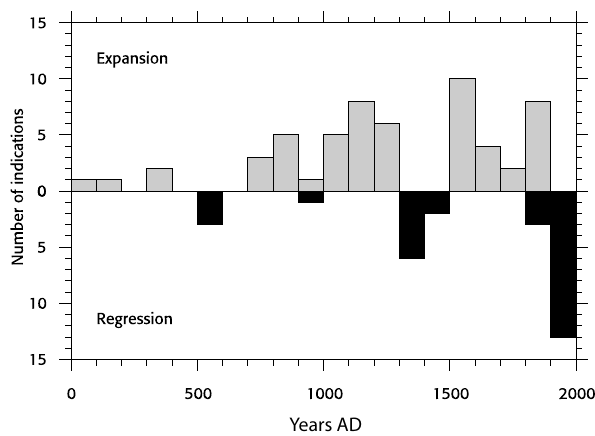
Fig. 5. Indicators of land-use expansion and regression during the last 2000 years in Southern Sweden (Lager˚as, 2006). The figure shows distinctive expansions during the early-Medieval period be- tween 700–1300AD and between 1500–1900AD (which overlaps with the Industrial Revolution). The late Medieval crisis (1300– 1500AD) is characterized by a marked land-use regression